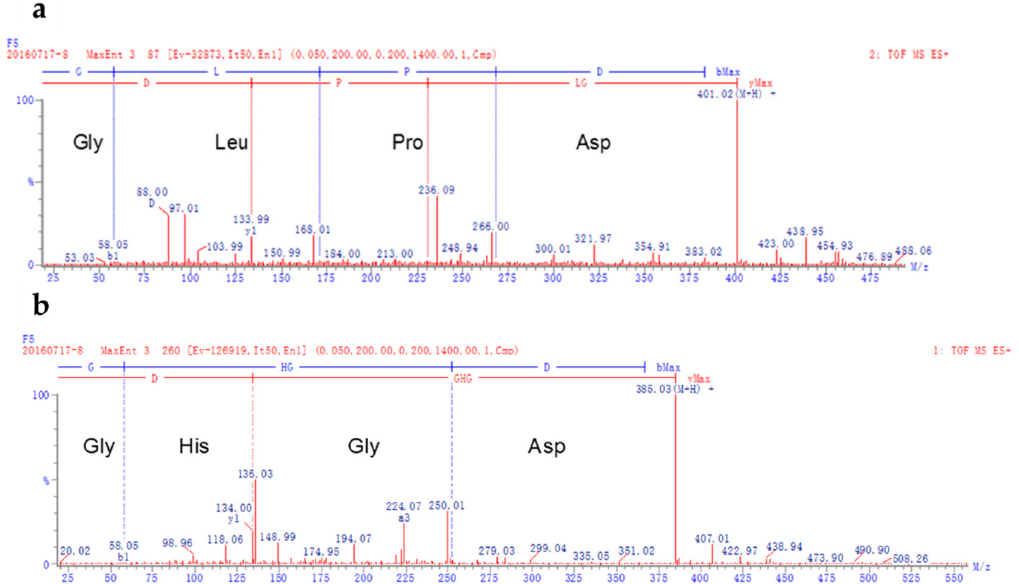
Figure 4. Liquid chromatography coupled quadruple time of flight mass spectrometry (LC-Q-TOF MS) spectrum (electrospray ionization (ESI + )) of the peptides Gly-Leu-Pro-Asp ( a ) and Gly-His-Gly-Asp ( b ) isolated from S5.1.